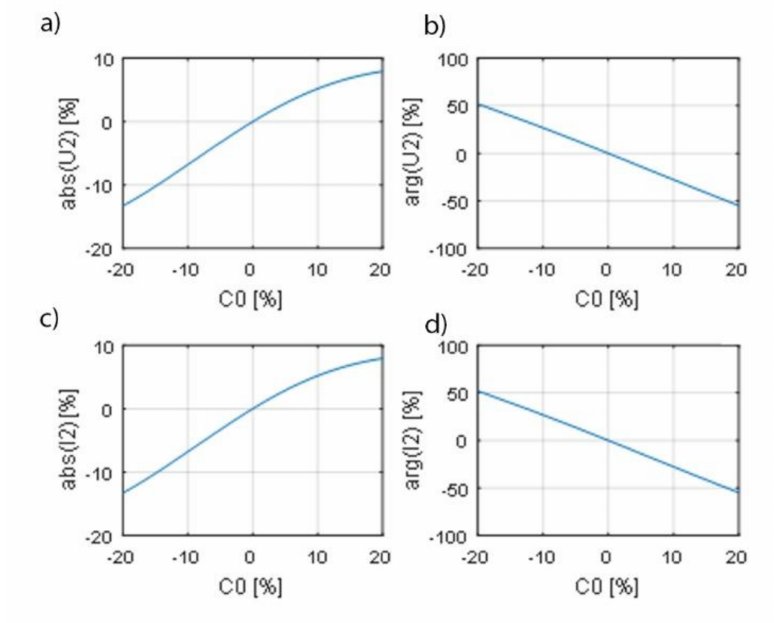
Figure 20. Changes of wave parameters depending on C 0 at f = 100 kHz; ( a ) U 2 voltage modulus, ( b ) U 2 argument, ( c ) I 2 modulus, ( d ) I 2